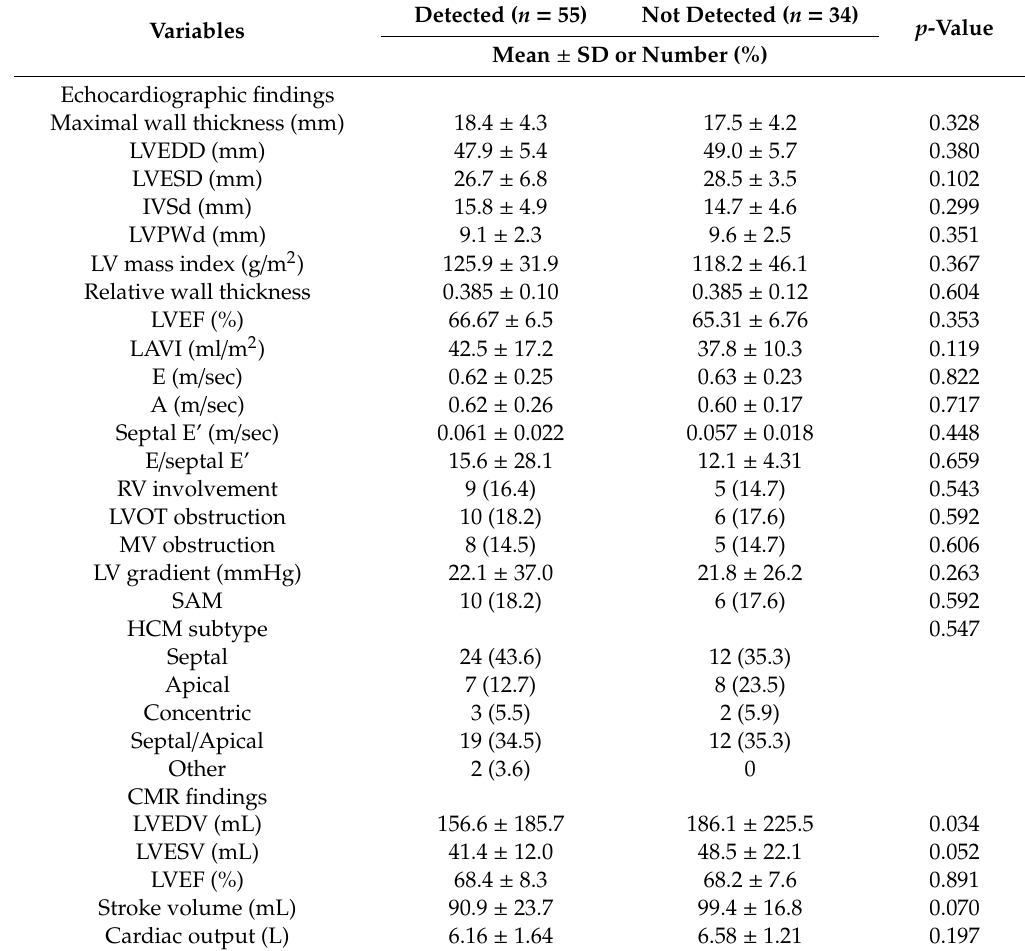
Table 4. Distribution of echocardiographic and cardiac magnetic resonance imaging findings.